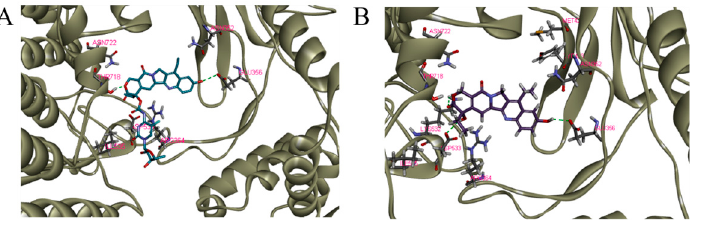
Figure 3. Representation of the binding modes of PCC0208037 ( A ) and SN-38 ( B ) with the complex conformation of DNA and Topo I (PDB code:1k4t). Key residues were in gray color and hydrogen bonds were represented with red lines.